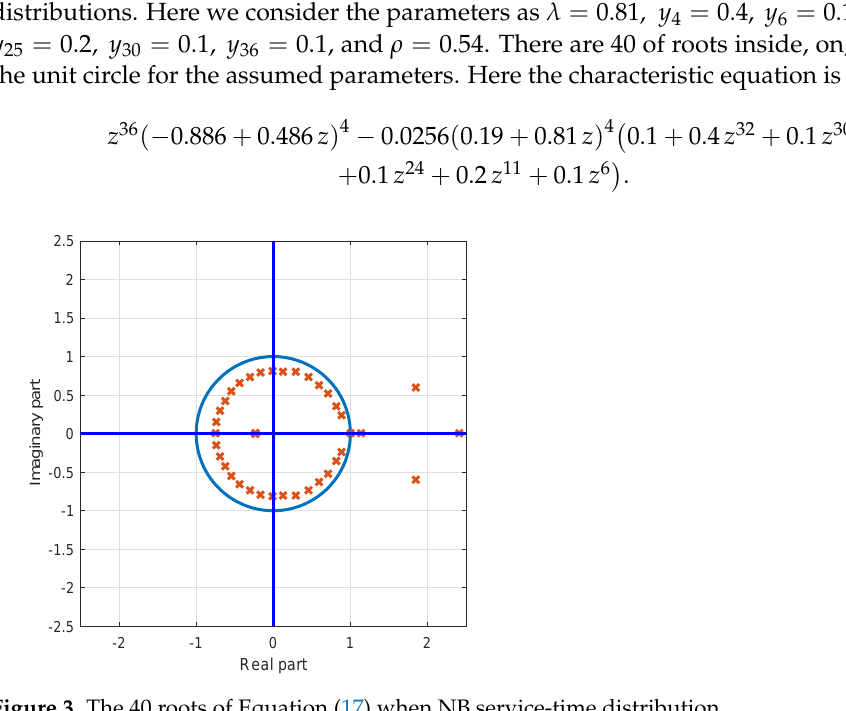
Figure 3. The 40 roots of Equation (17) when NB service-time